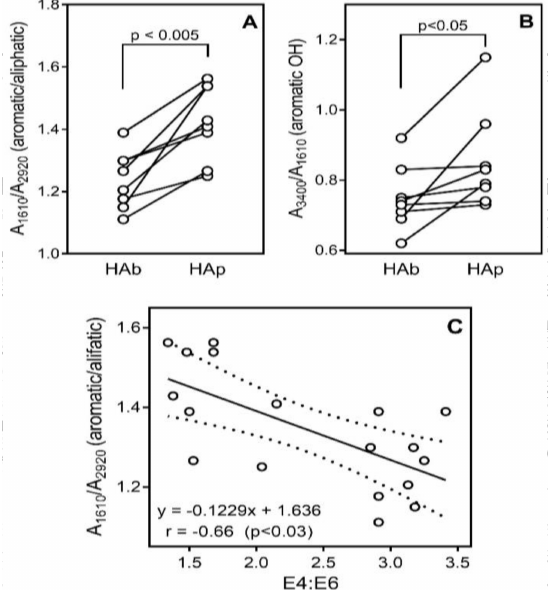
Figure 1. Relative concentrations of functional groups in HA fractions estimated as a ratio of intensity of the absorption bands in the IR region. A 1610 , A 2920 , and A 3400 are optical densities for aromatic (C=C), aliphatic, and OH groups, respectively. ( Panels A , B ) show differences in the ratios of the absorption bands between HAb and HAp fractions. ( Panel C ) shows a plot of A 1610 /A 2920 versus E4:E6 for all 18 HA fractions. Dashed lines indicate area of the 95% confidence